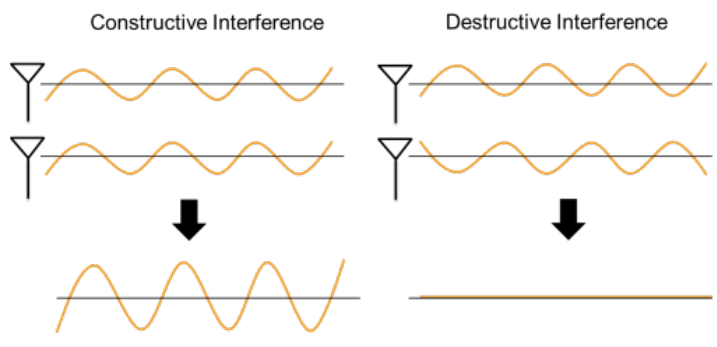
Figure 4. Constructive and destructive interference of waves.